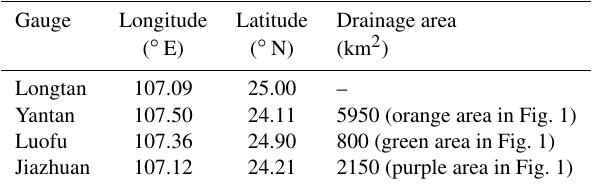
Figure 1. Locations of discharge gauges and rain gauges over the Yantan Basin. Table 1. Information on hydrological